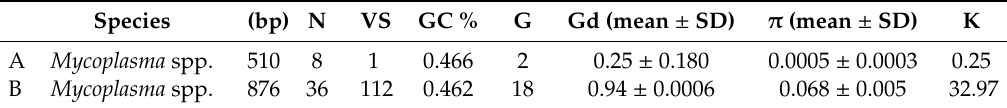
Table 2. Polymorphism and genetic diversity of 16S rDNA hemotrophic Mycoplasma spp. sequences detected in rodents from the Valdivia province, Chile (A), and combined with those previously detected in rodents from several worldwide regions (B).